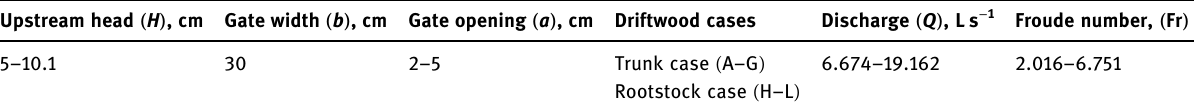
Table 5: Experimental data ranges